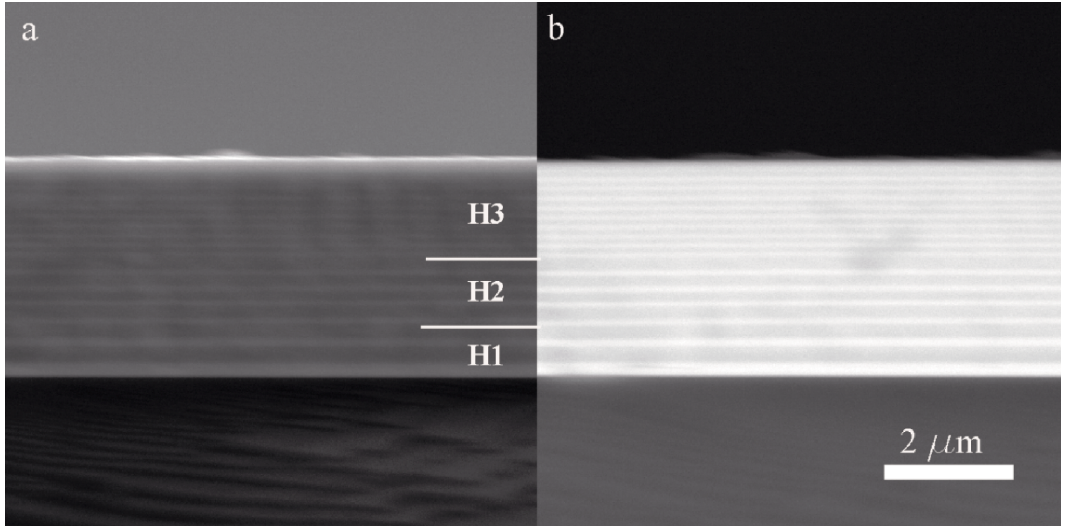
Figure 2. FESEM images of the cross-section of the HIER-TaN/N sample. ( a ) Secondary electron image, where three periodicity sections are marked. ( b ) Electron backscattering images where the visualization of all the layers is easier.